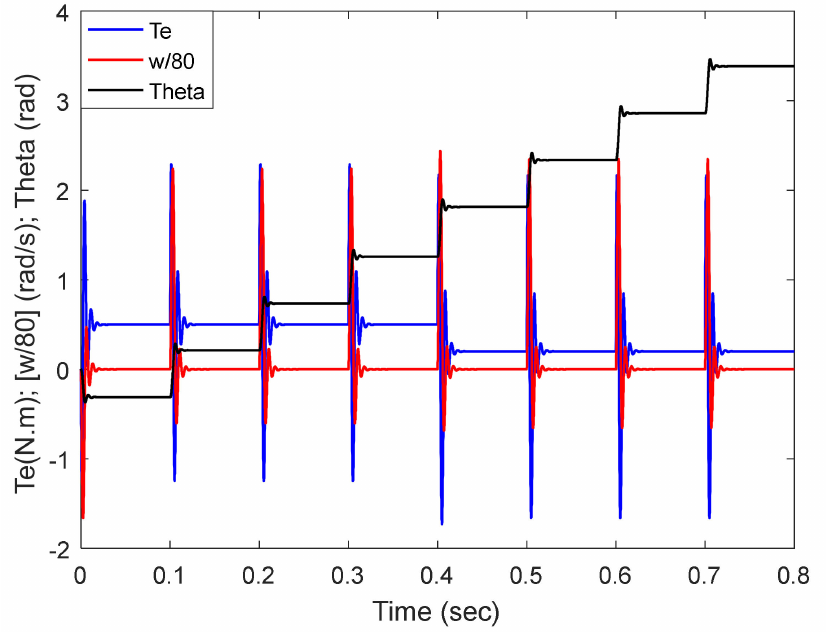
Figure 12. Characteristic of stepper motor at period signal 0.4 s and changing load torque from 0.5 to 0.2